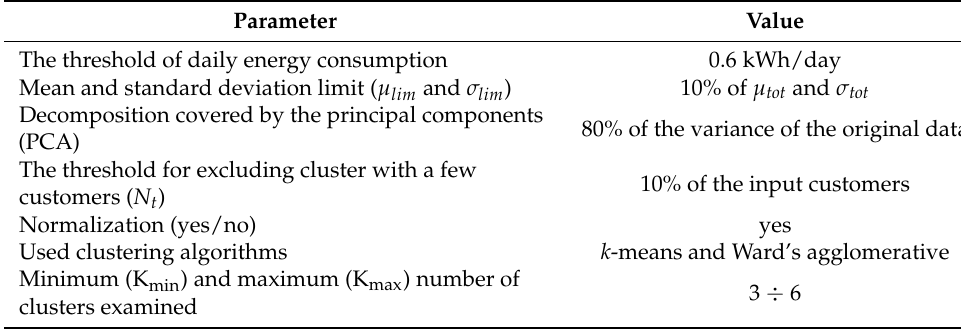
Table 2. Parameters useful for grouping customers into classes (second